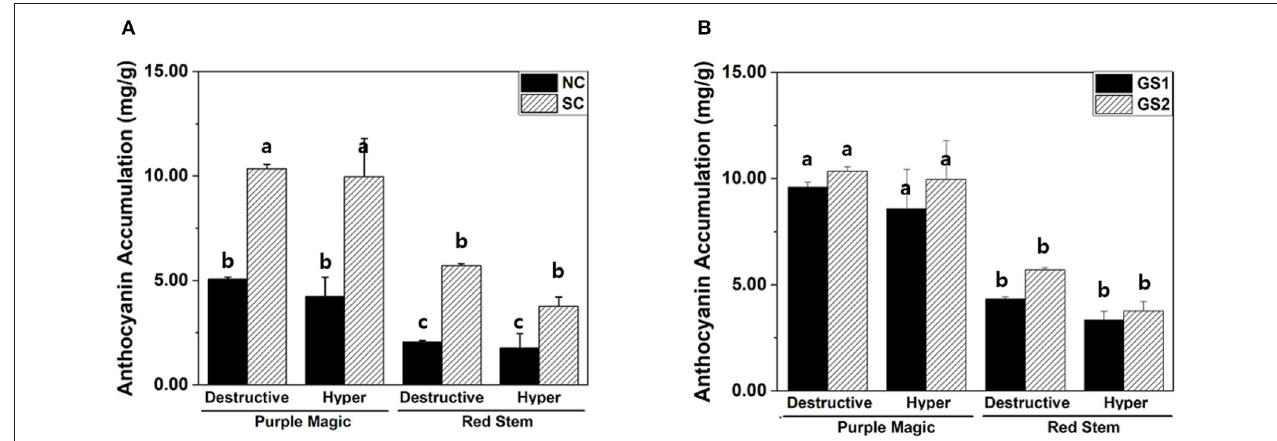
FIGURE 3 | Variation in anthocyanin accumulations (mg/g DW) of purple magic and red stem estimated by different cultivation conditions. (A) Destructive and hyperspectral analysis with non-stimulation and stimulation conditions. (B) Destructive analysis and hyperspectral analysis by cultivation period for 2 weeks (GS1) and 4 weeks (GS2). These data were obtained from the second experiment described in the Materials and methods section. Means with a different letter are significantly different at P ≦ 0.05, using Fisher’s LSD analysis.